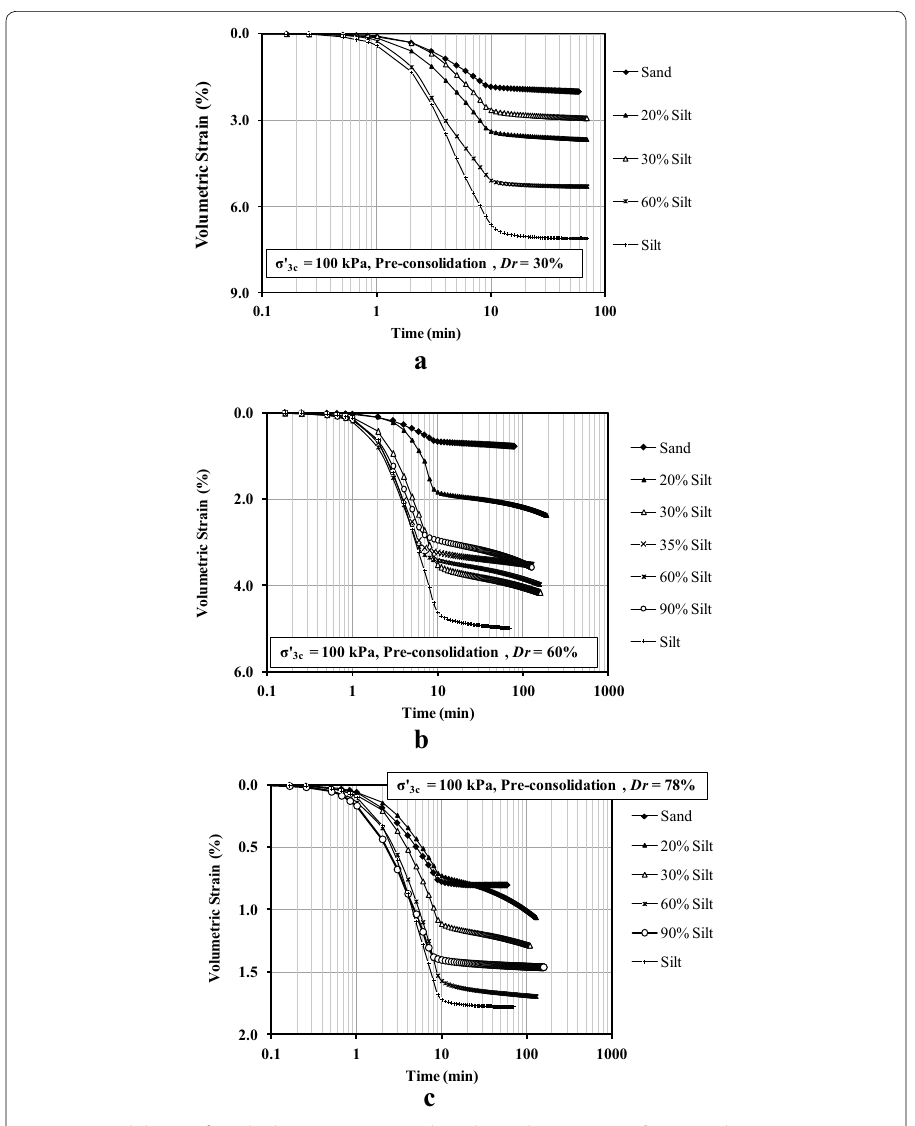
Fig. 6 Consolidation of sand–silt mixtures prepared at relative density. a 30%, b 60% and c